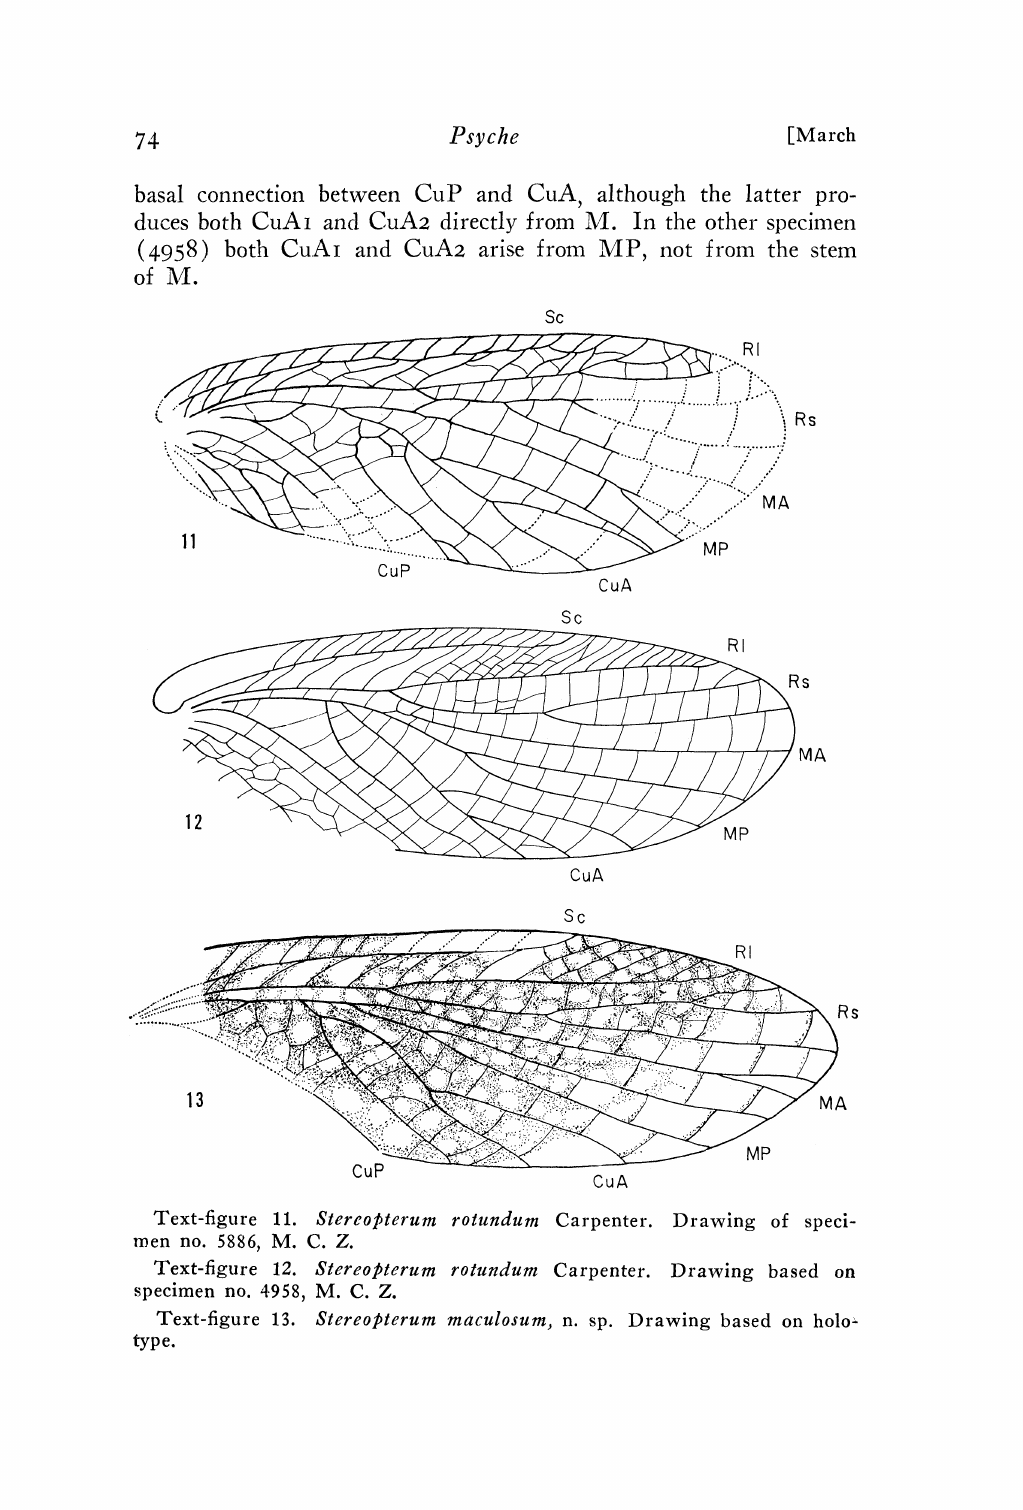
Text-figure 11. Stereotterum rotundum Carpenter. Drawing o] speci- men no. 5gg6, M. C. 2:. Text-figure 12. 8tereolbterum rotundum Carpenter. Drawing based on specimen no. ’-1-95S, M. C. Z. Text-figure 13. SlgreoIlerum marulosum, n. sp. Drawing based on holo